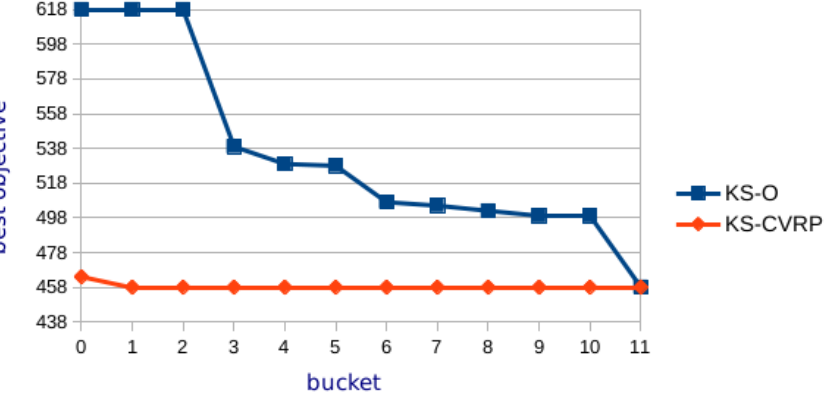
Figure 3. Evolution of solution improvement by different methods.